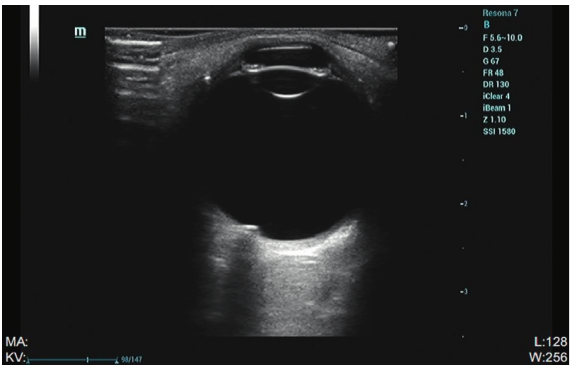
Figure 3: B-mode ultrasonography findings of a patient with ODD. B-mode ultrasonography shows discoid strong echoes with ir- regular flat protuberances in the optic disc.